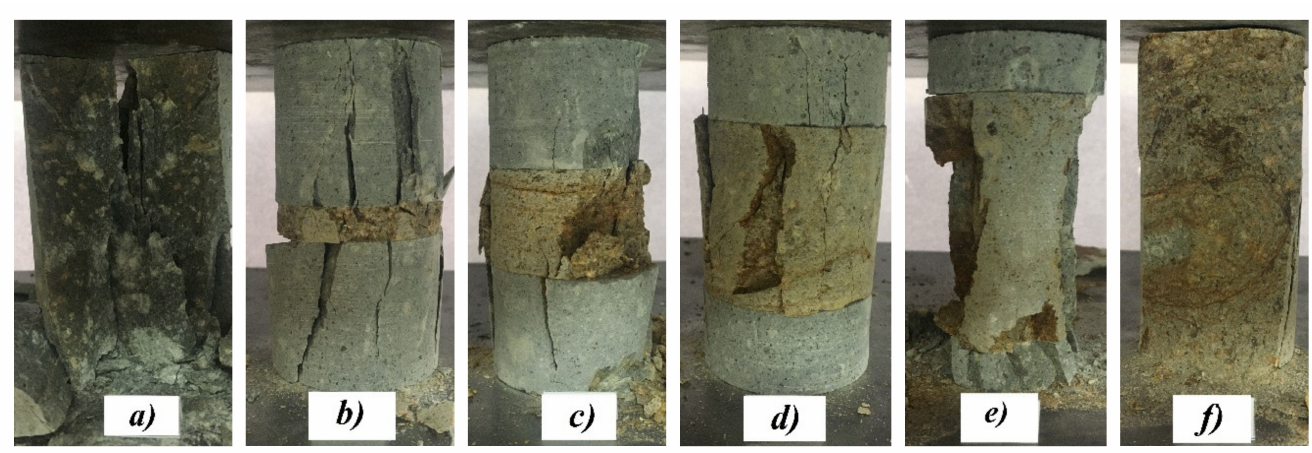
Figure 7. Specimens after testing—UCS: ( a ) 0% AD, ( b ) 10% AD, ( c ) 30% AD, ( d ) 50% AD, ( e ) 70% AD, ( f ) 100 % AD. A diagram of the dependence of the UCS ( σ ciUCS ) on the volumetric participation of altered dacite ( AD %) was drawn based on the test results (Figure 8). According to the previously performed research [1,6], the results were approximated by an exponential and linear